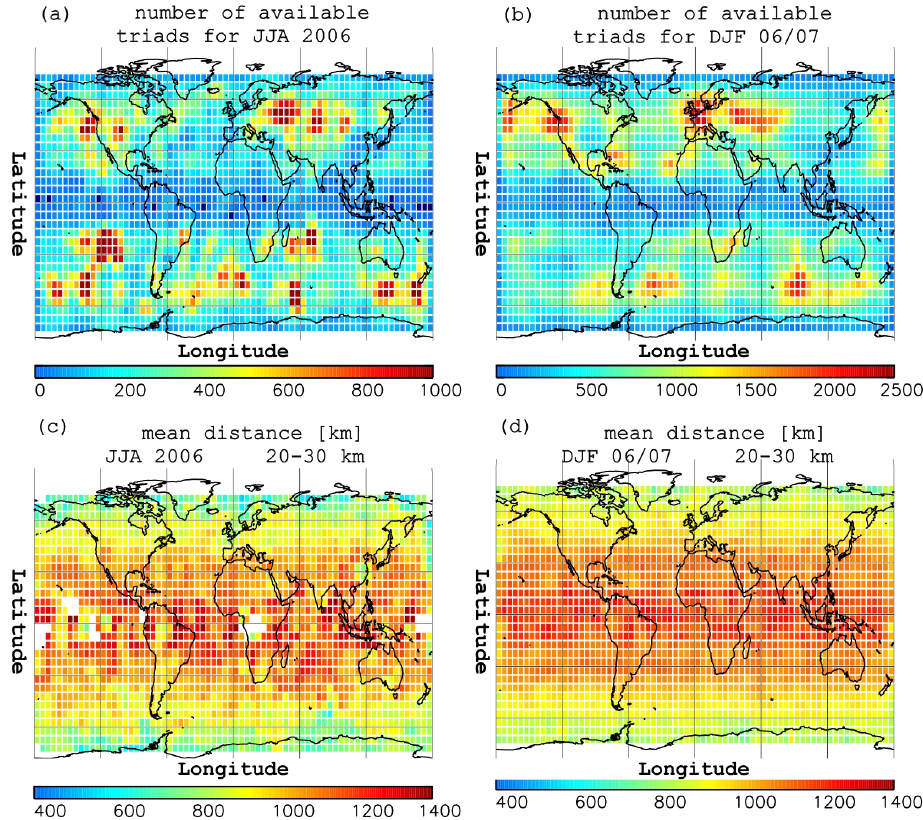
Fig. 8. Number of 3-point groupings from COSMIC for JJA 2006 ( a ) and DJF 2006/2007 ( b ) and the mean horizontal distance of the three single profiles within each 3-point grouping ( e and f ) for the altitude range of